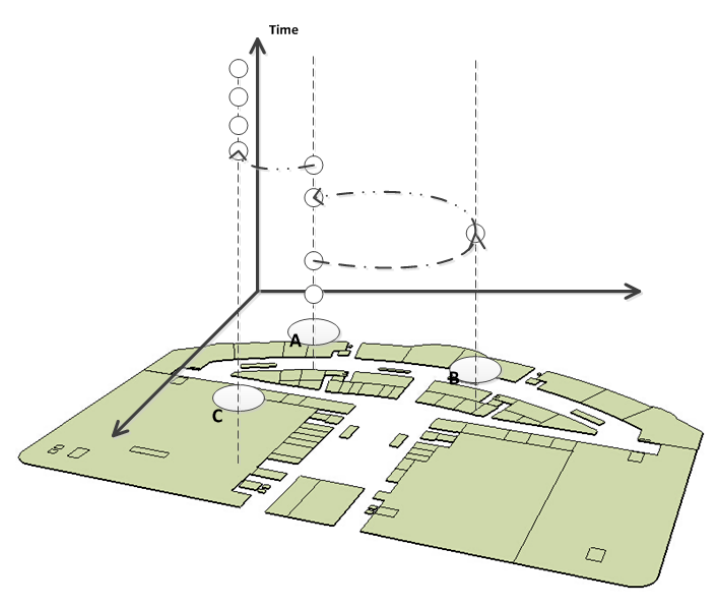
Figure 9. Sketch map of the drift phenomenon.